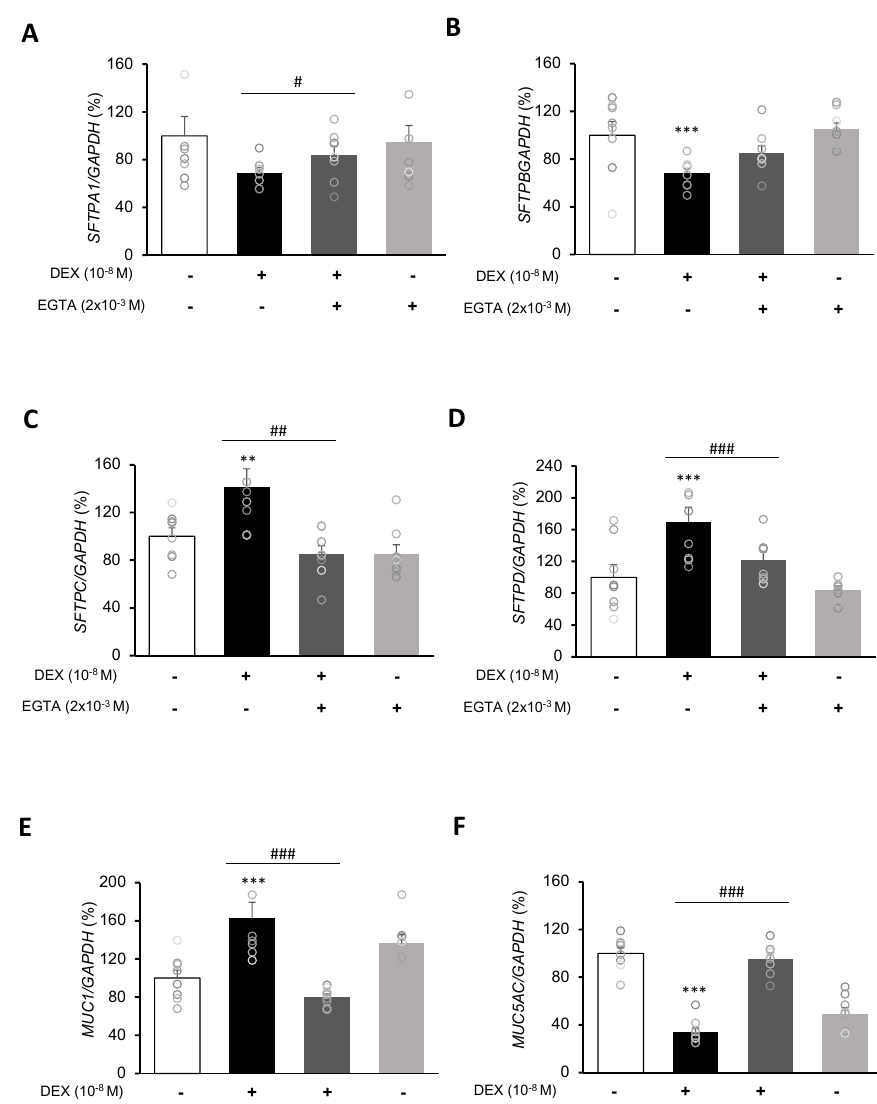
Figure 6. E ff ect of EGTA on surfactant protein and mucin genes in A549 cells. E ff ect of EGTA and DEX on the transcriptional level of ( A ) surfactant protein A (SFTPA), ( B ) surfactant protein B (SFTPB), ( C ) surfactant protein C (SFTPC), ( D ) surfactant protein D (SFTPD), ( E ) mucin 1 (MUC1), and ( F ) mucin 5AC (MUC5AC) by real-time PCR. The mRNA level was measured by performing real-time PCR and was normalized by GAPDH. ** p < 0.01 versus Control; *** p < 0.001 versus control; # p < 0.05 versus EGTA; ## p < 0.01 versus EGTA; ### p < 0.001 versus EGTA.